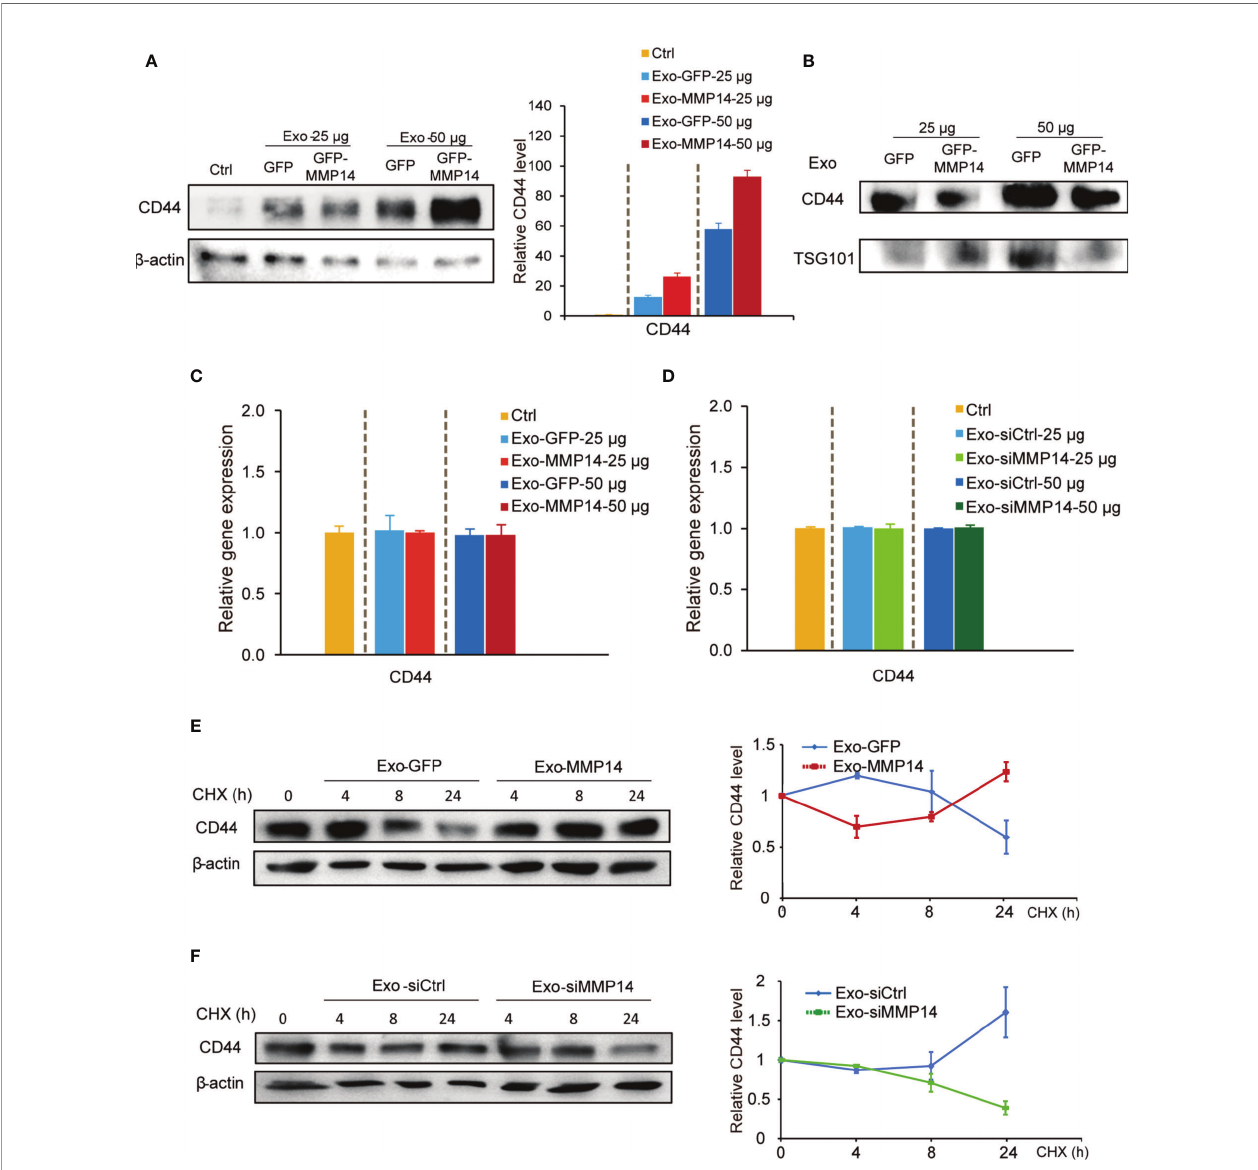
FIGURE 6 | Exosome-transferred MMP14 promotes CD44 stability of the sensitive PDAC cells. (A) Immunoblotting assay of CD44 expression in BxPC-3 cells incubated with indicated amounts of exosomes from MMP14-overexpressing or control PANC-1 cells for 48 hours. actin was used as loading control. (B) Immunoblotting assay of CD44 expression in the exosomes extracted from MMP14-overexpressing or control PANC-1 cells. The amounts of loading exosomes (25 or 50 µg) were shown. TSG101 was used as the exosome marker. (C) RT-qPCR analysis of CD44 mRNA level in BxPC-3 cells incubated with indicated amounts of exosomes from MMP14-overexpressing or control PANC-1 cells for 48 hours. CD44 expression in relative to GAPDH was normalized to control. (D) RT-qPCR analysis of CD44 mRNA level in BxPC-3 cells incubated with indicated amounts of exosomes from MMP14-knockdown or control BxPC-3-Gem cells. CD44 expression in relative to GAPDH was normalized to control. (E) Immunoblotting assay of CD44 expression in BxPC-3 cells incubated with exosomes from MMP14- overexpressing or control PANC-1 cells and treated with CHX (100 µg/mL) for up to 24 hours (left). Quanti fi cation of CD44 was normalized to the loading control and expressed relative to 0 hour (right). (F) Immunoblotting assay of CD44 expression in BxPC-3 cells incubated with exosomes from MMP14-knockdown or control BxPC-3-Gem cells and treated with CHX (100 µg/mL) for up to 24 hours (left). Quanti fi cation of CD44 was normalized to the loading control and expressed relative to 0 hour (right). Representative images above were from three independent experiments. Data in (E, F) are presented as mean ± ( Figure 6E ). Moreover, the exosomes from MMP14 knockdown BxPC-3-Gem cells led to CD44 protein levels dramatically decreasing in BxPC-3 cells in comparison with the control cells ( Figure 6F ). These results indicate that exosome-transferred MMP14 promotes CD44 stability in recipient cells.